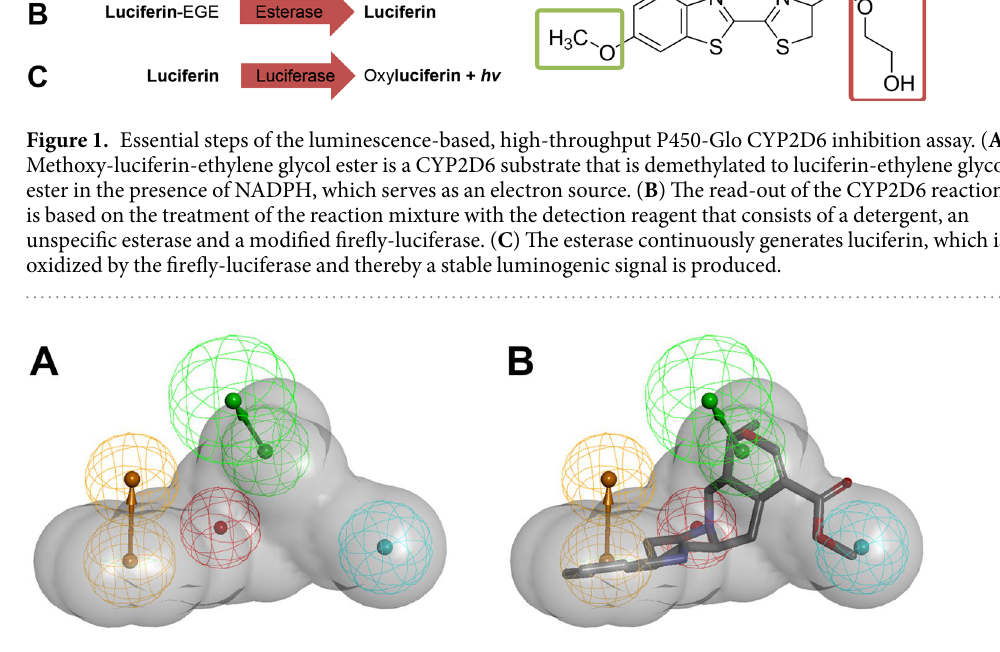
Figure 2. ( A ) The pharmacophore model consisting of typical physicochemical features for CYP2D6 inhibitors. Chemical features are color-coded: hydrophobic - cyan, hydrogen bond acceptor - green, positively ionisable group - red, aromatic ring - orange, shape and size restriction - grey. ( B ) The 3D structure of the known inhibitor ajmalicine is fitted into the